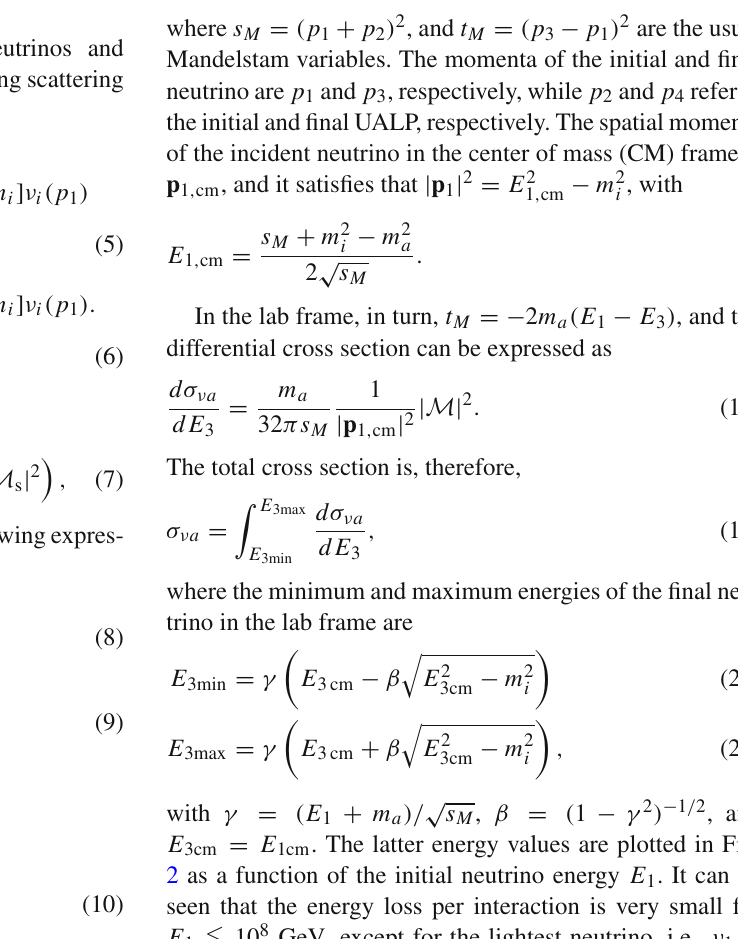
Fig. 1 Neutrino-UALP interaction channels considered